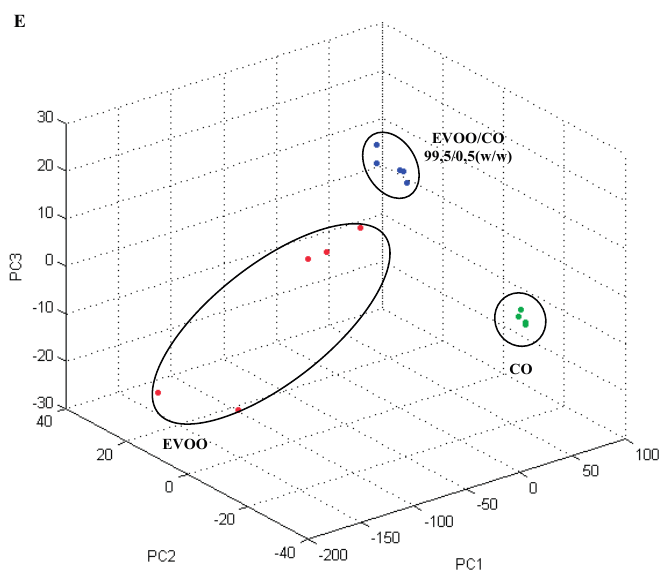
Figure 4. 3D scatter plots of the first three PC for the five mixtures (20%, 10%, 5%, 1% and 0.5%), obtained by adding CO ( A – E ) to EVOO. All EVOO, CO and oil adulterations replicas grouped inside correct